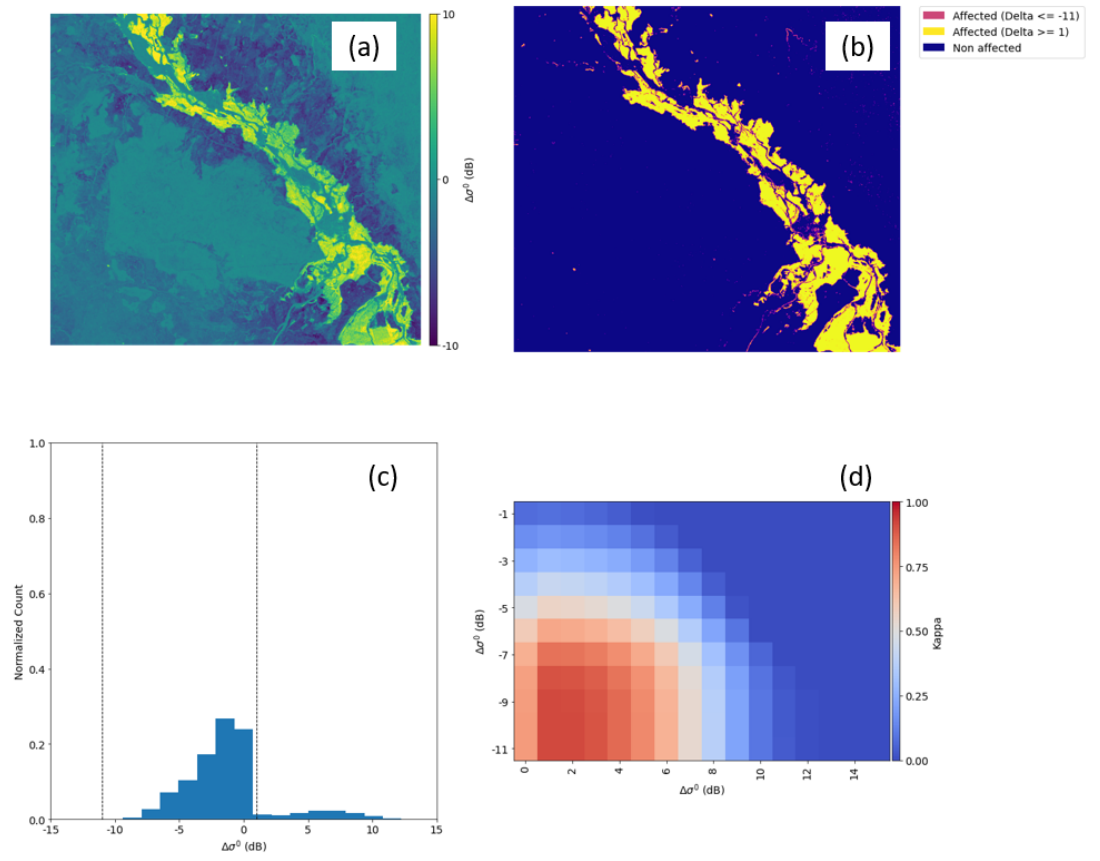
Figure 10. Australia ConvLSTM Delta image of VH polarization ( a ), Flood Proxy Map ( b ), Histogram of Delta image ( c ), and Cohen’s Kappa heatmap ( d ).